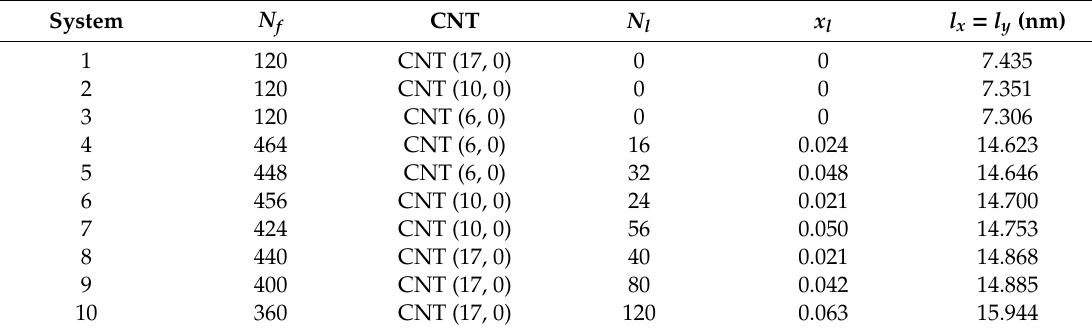
Table 1. Description of systems simulated in this work.